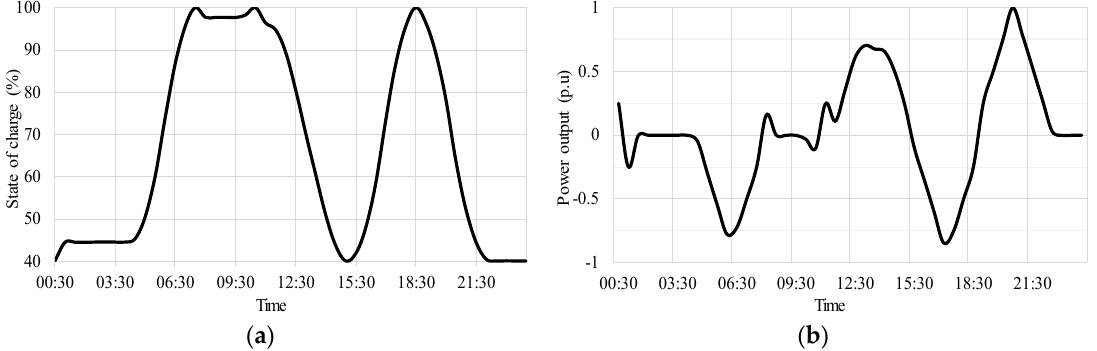
Figure 9. Battery SOC and power output for a typical summer day: ( a ) State of charge; ( b ) Power output.